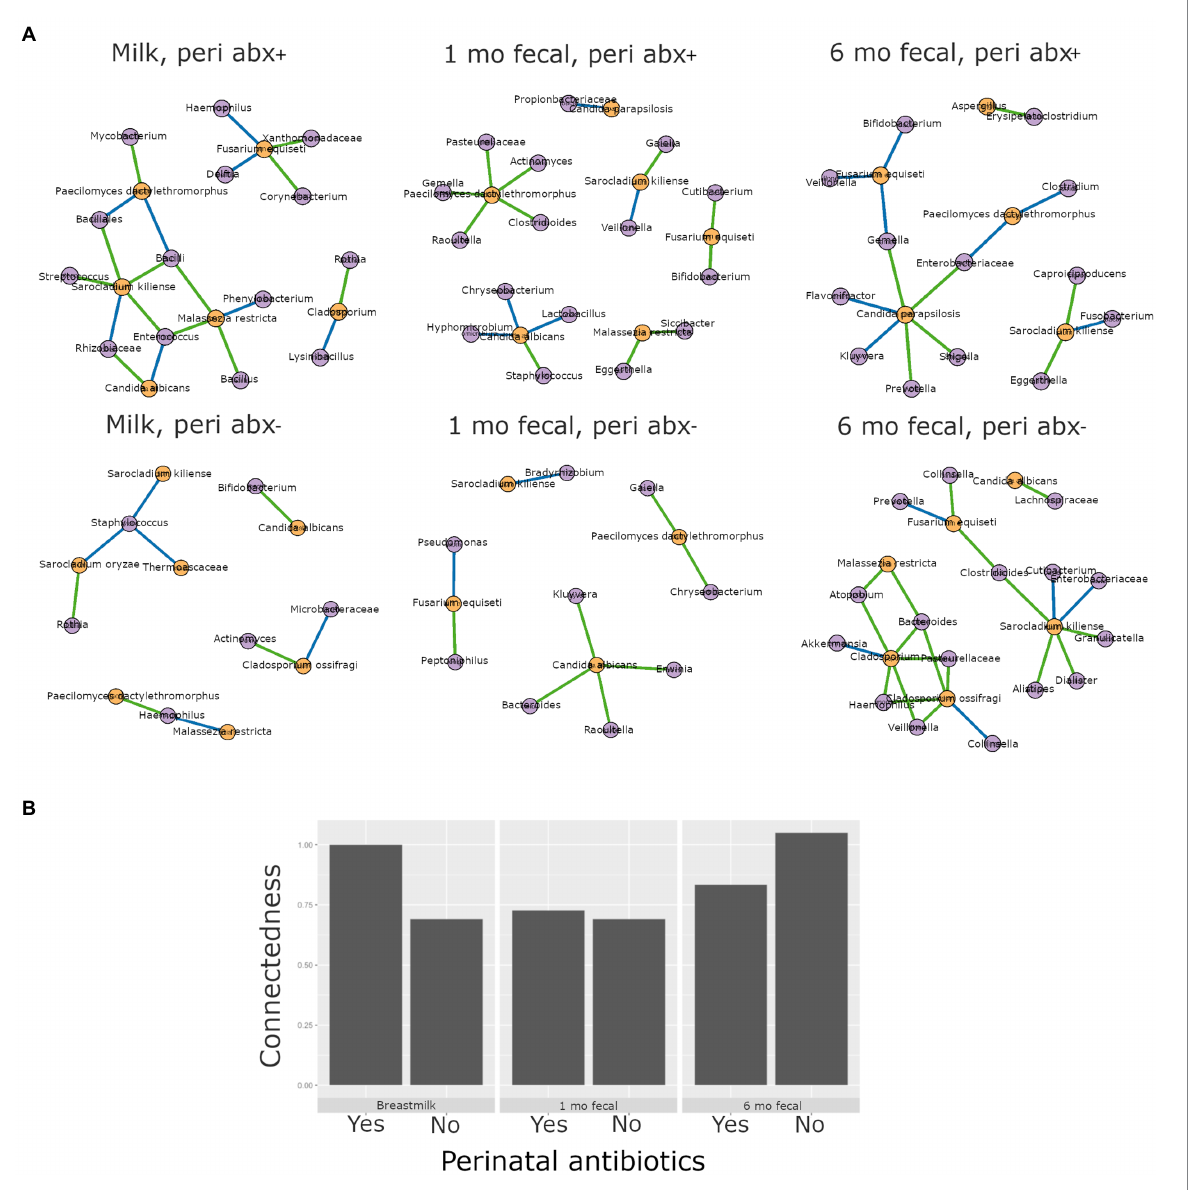
FIGURE 7 Interkingdom relationship comparisons by perinatal antibiotic exposure. Panels in A are interkingdom network maps of significant interactions between bacterial (purple) and fungal (orange) taxa and are organized by sample type. Blue line, negative correlation; green line, positive correlation. Plot in B is of interkingdom connectedness values (see Methods) by sample type. Sample n’s included in network analyses for Perinatal antibiotic-exposed (peri abx +, top row): breastmilk 19, 1-month feces 26, 6-month feces 18 and for Perinatal antibiotics unexposed (peri abx -, bottom row): breastmilk 55, 1-month feces 72, 6-month feces